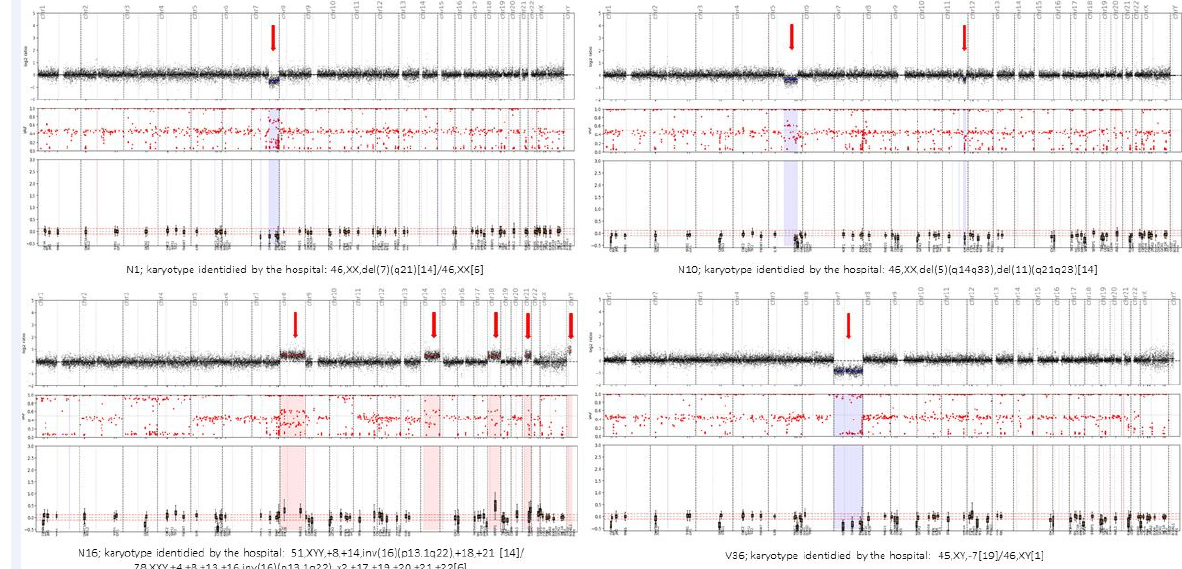
Figure 2. Comparative examples between the conventional karyotype reported by the hospital and the CNV plot obtained using the Haematology OncoKitDX. The arrows indicate the gains and losses of chromosomal material evidenced by the bioinformatics pipeline, which is based on the off-target of the panel. The central image of small red dots is obtained from 996 SNPs distributed throughout the genome. The loss of heterozygosity that is detected in the regions affected by a CNV reinforces the gain or loss detected by means of the off-target-based pipeline. The lower image of each example represents the target genes of the panel in their chromosomal